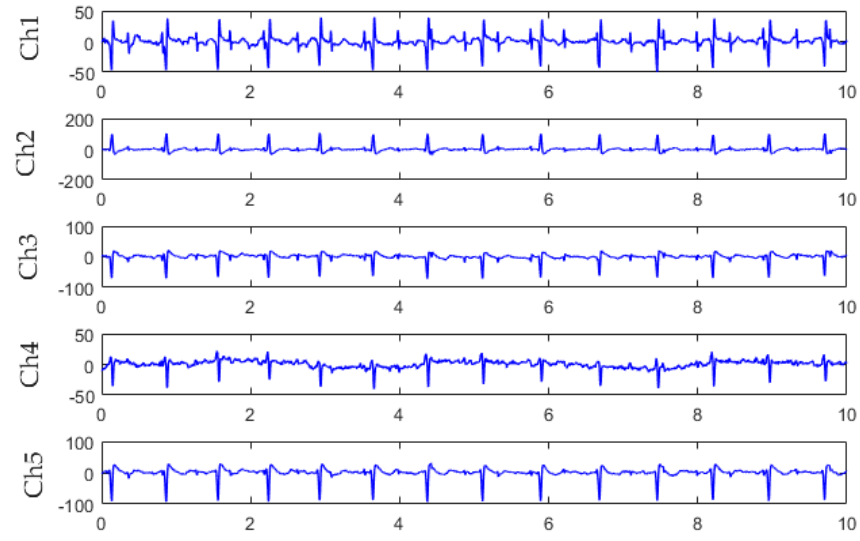
Figure 8. Five-channel abdominal signals from the DaIsy database.